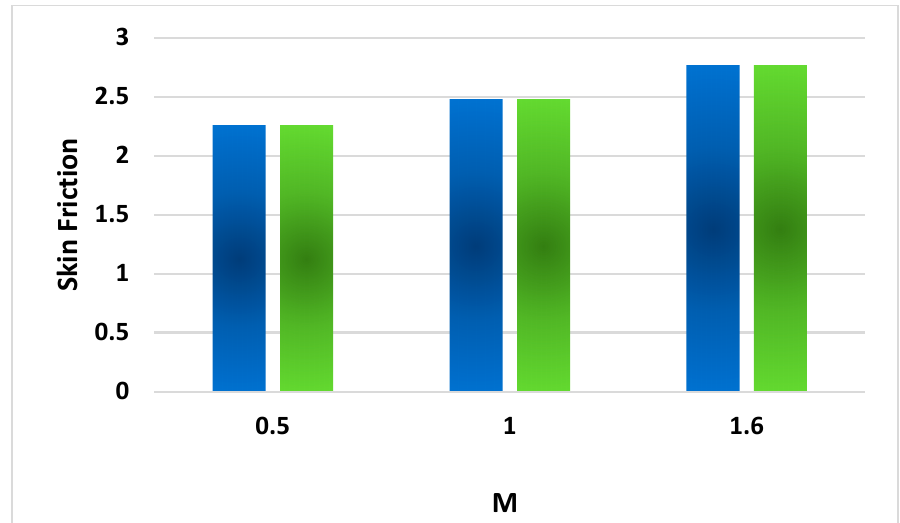
Figure 18. Revealing the consequences of M with the related skin friction coefficient.